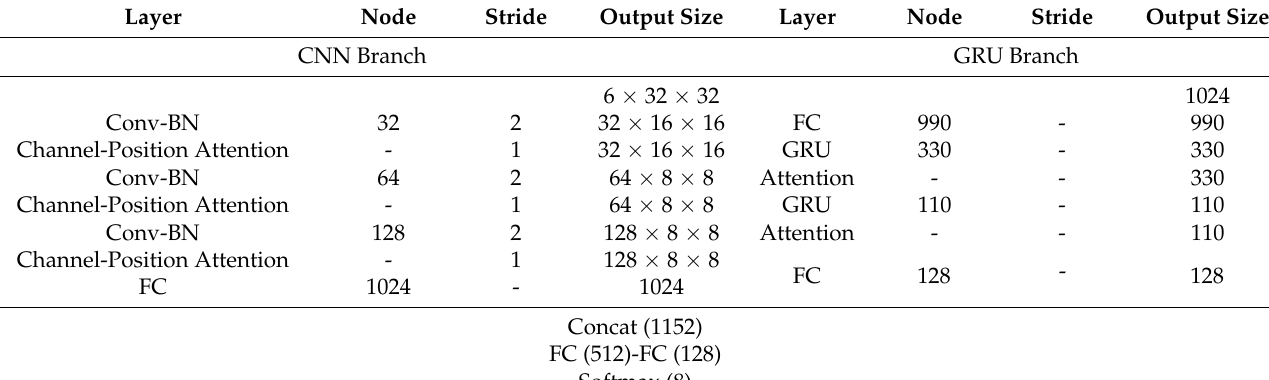
Table 1. The STNet’s